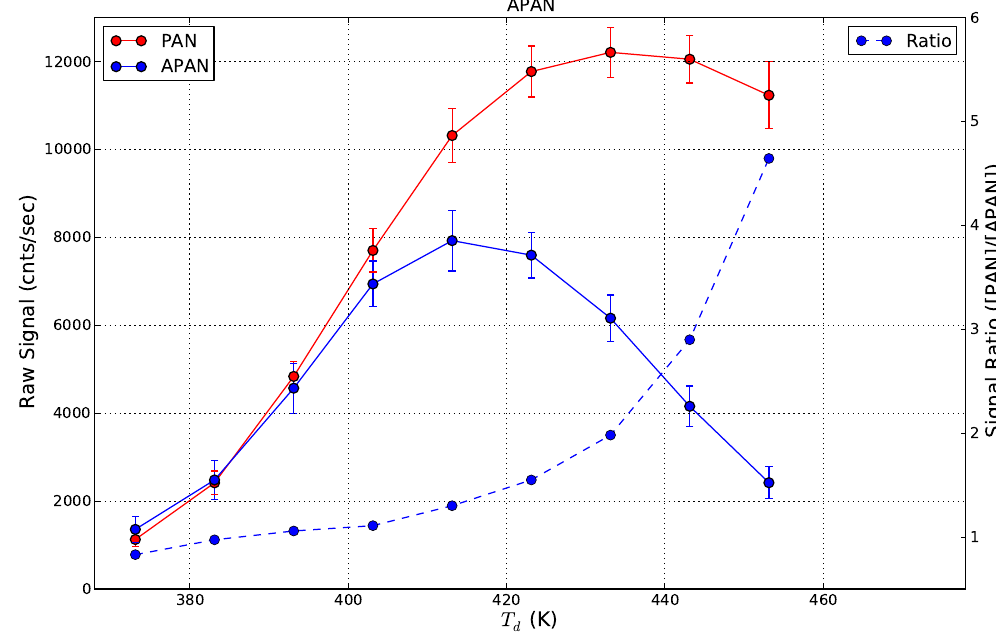
Fig. 5. The variation of the APAN signal compared to PAN as a function of the thermal dissociation temperature ( T d ) .